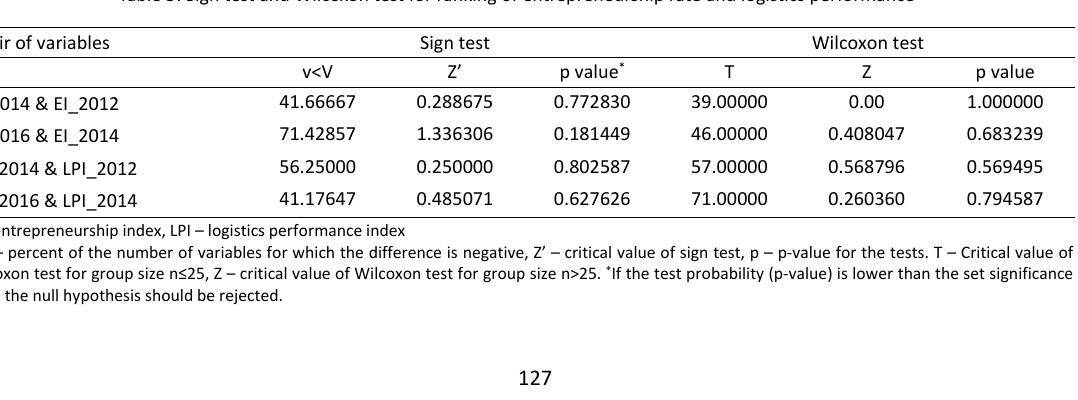
Table 4: Sign test and Wilcoxon test for development measures of entrepreneurship rate and logistics performance A pair of variables